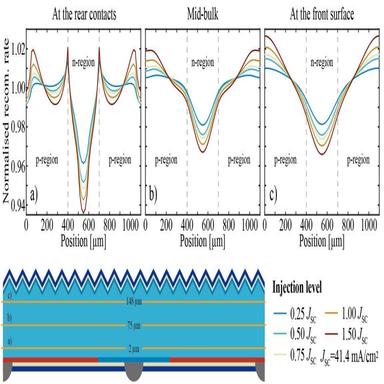
Simulated radiative recombination profiles normalised to their mean value at different injection levels, a) at the rear contacts, b) mid-bulk, and c) near the top surface.